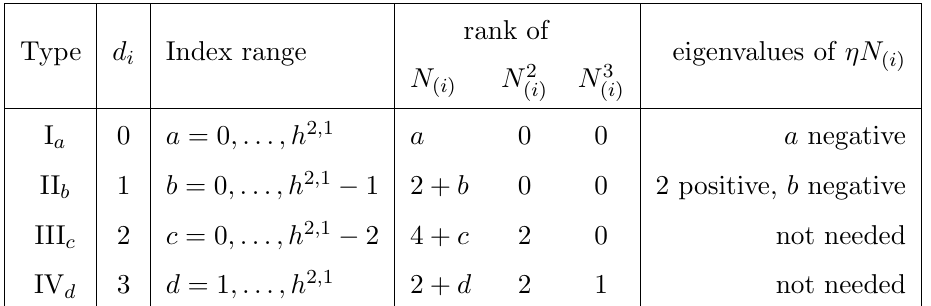
Table 1 . Classi(cid:12)cation of limits in the complex moduli